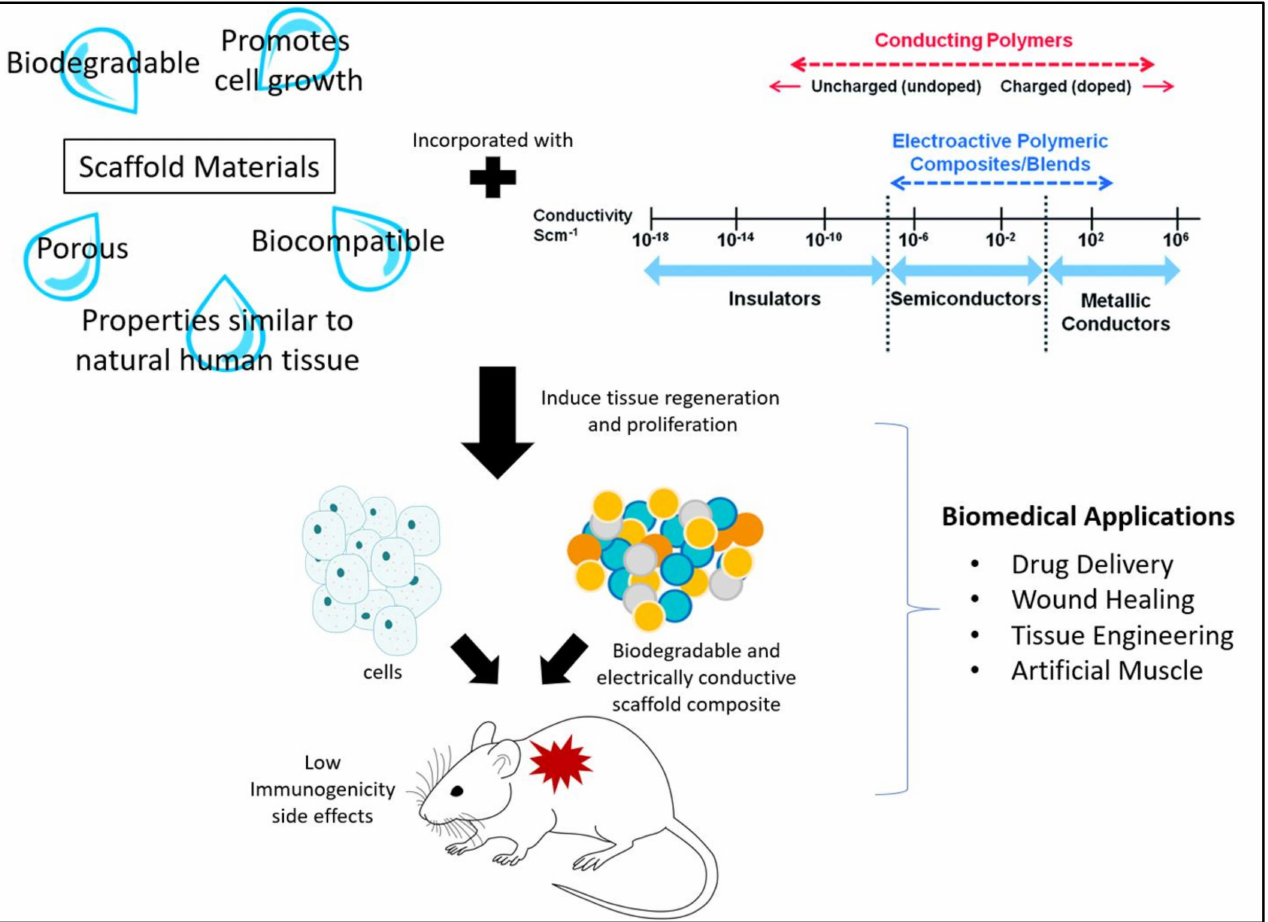
Figure 2. Illustration of the use of biodegradable and electrically conductive materials to promote cell growth with low